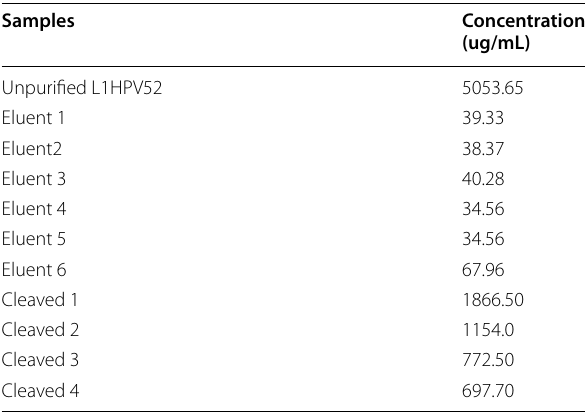
Table 2 Quantification of total protein concentration of recombinant L1-HPV52